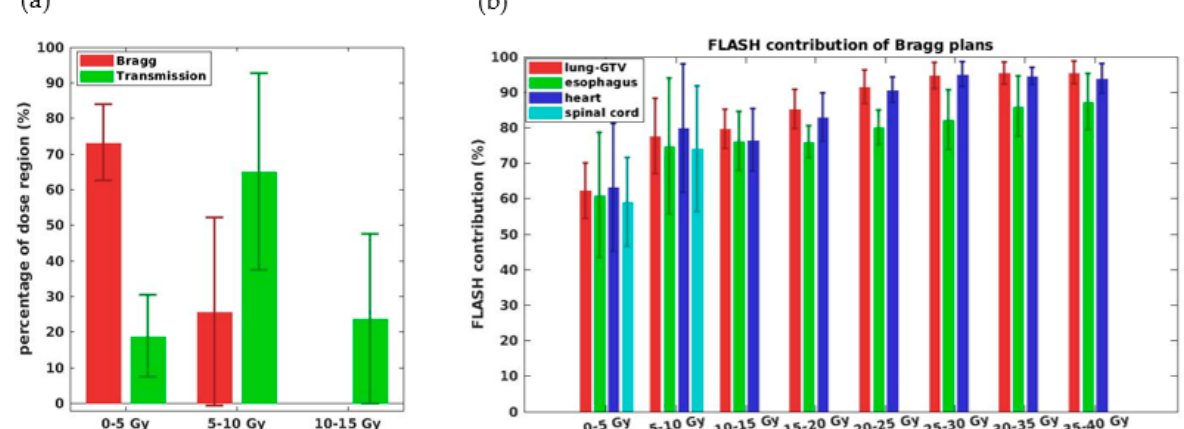
Figure 5. ( a ) Ratio of spinal cord volume in different dose regions for both Bragg peak and transmission plans, noting that the spinal cord has a larger portion receiving dose between 0–5 Gy in the Bragg peak plans than the transmission plans. ( b ) FLASH dose rate coverage V40 Gy/s (based on ADR calculations) distribution vs. different dose regions for major OARs. Note the low dose region of the OARs 0–5 Gy is associated with the lowest FLASH contributions.